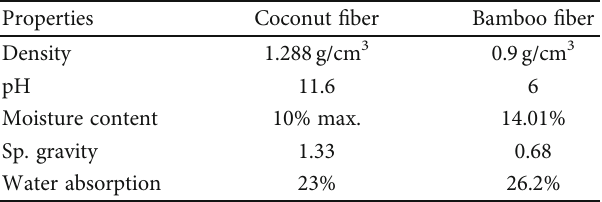
Figure 2: Bamboo and coconut shell powder. Table 1: Properties of coconut fi ber and bamboo fi ber.